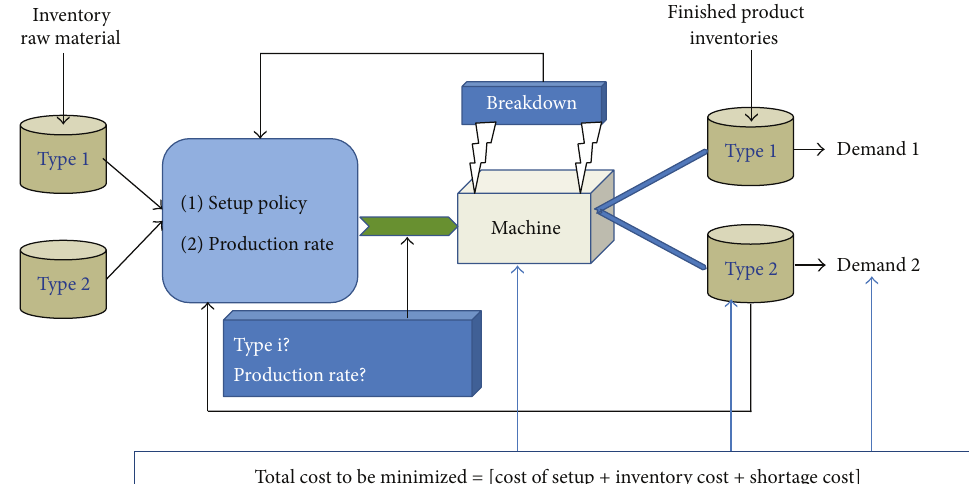
Figure 1: Manufacturing system